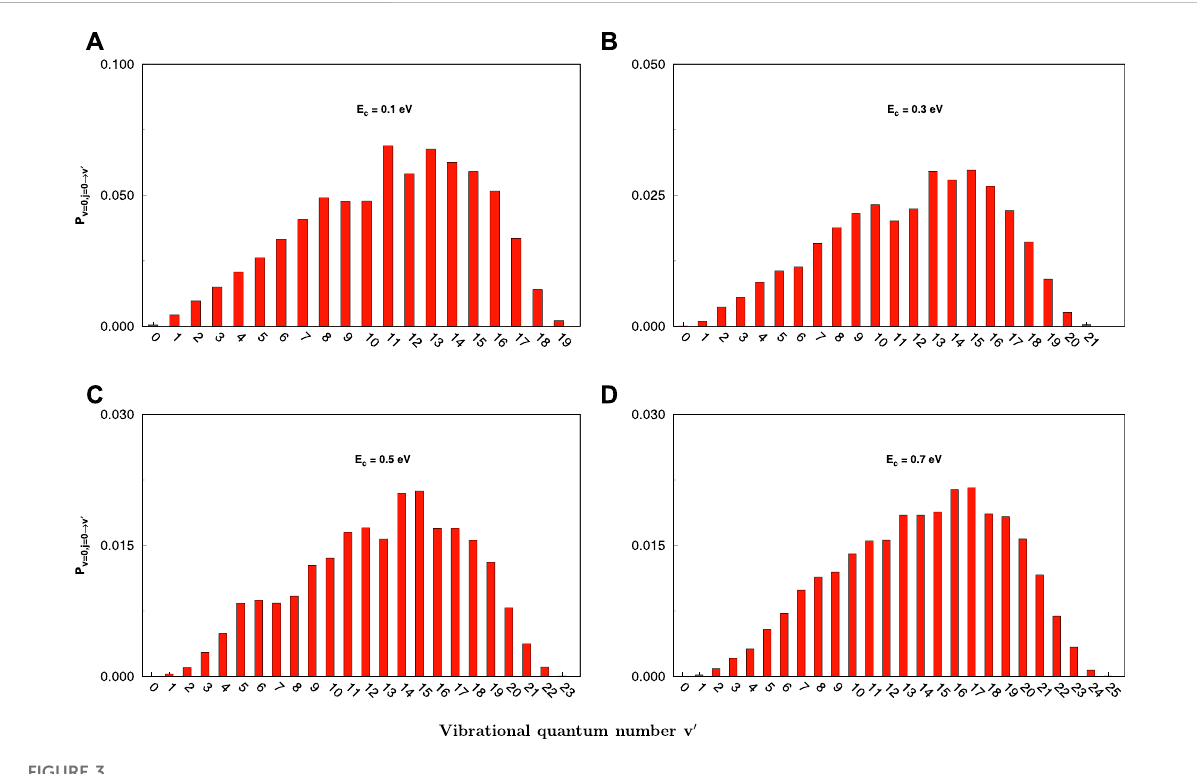
FIGURE 3 Final v ′ state-resolvedreactionprobabilitiesat J =0fortheC + +SH( v =0, j =0) → H+CS + ( v ′ )reactionatselectedcollisionenergies(0.1,0.3,0.5, and 0.7 eV) obtained with the QCT method. (A) for 0.1 eV, (B) for 0.3 eV, (C) for 0.5 eV, (D) for 0.7